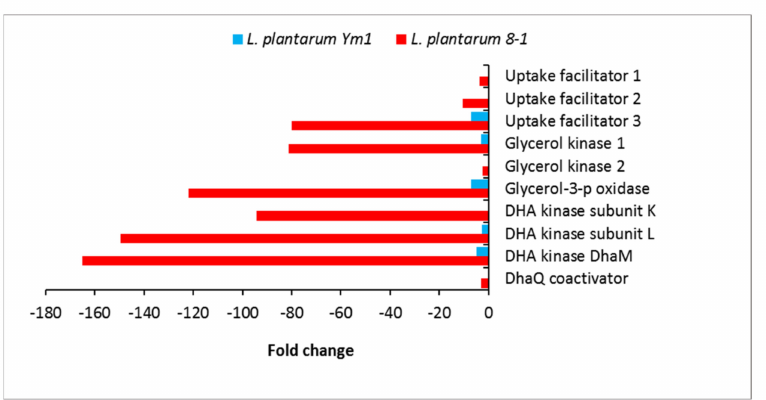
Figure 8. Differentially expressed genes (DEGs) involved in glycerol uptake and conversion in L. plantarum strains Ym1 and 8-1 during butanol stress. Lp_0108, lp_0372, and lp_0171 encode glycerol uptake facilitator proteins GlpF 1, 2, and 3, respectively; lp_0370 and lp_0834 ( glpK ) encode glycerol kinase 1 and 2,